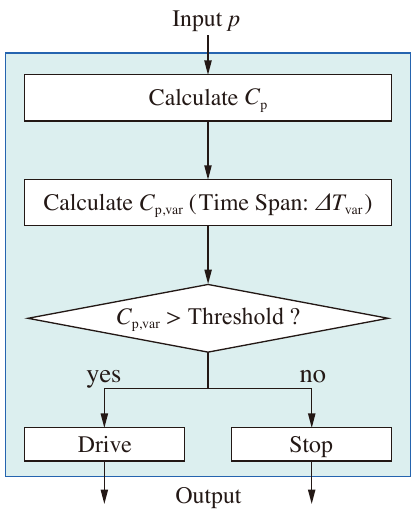
Figure 7. Control flowchart of FTM.